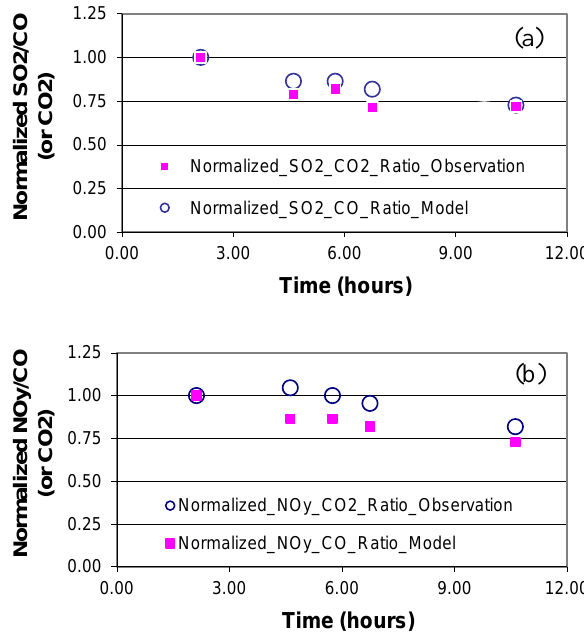
Fig. 8. The least-square-fit slopes of SO 2 to CO 2 (from the obser- vation) and SO 2 to CO (from the model) (a) , and the least-square-fit slopes of NO y to CO 2 (from the observation) and NO y to CO (from the observation) (b) . All slopes are normalized to the slope at the first transect.